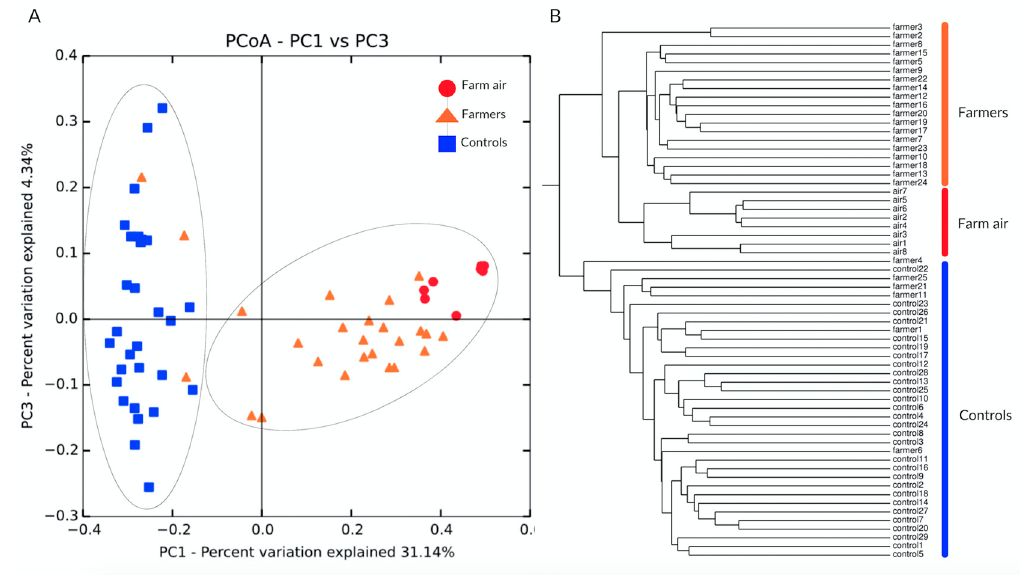
Figure 3. Pairwise sample dissimilarity compares the nasopharynxes of farmers and of non-exposed controls and air from pig buildings. The pairwise distances were calculated using the weighted UniFrac distance metric. ( A ) Principal coordinate analysis plot showing distances in the composition of the microbiota from three groups of samples. ( B ) Phylogram showing sample clustering using the unweighted pair group method with arithmetic mean. The clustering (air from pig buildings and pig farmers together, versus the non-exposed controls) was statistically significant as confirmed by the PERMANOVA test ( p -value = 0.0001).